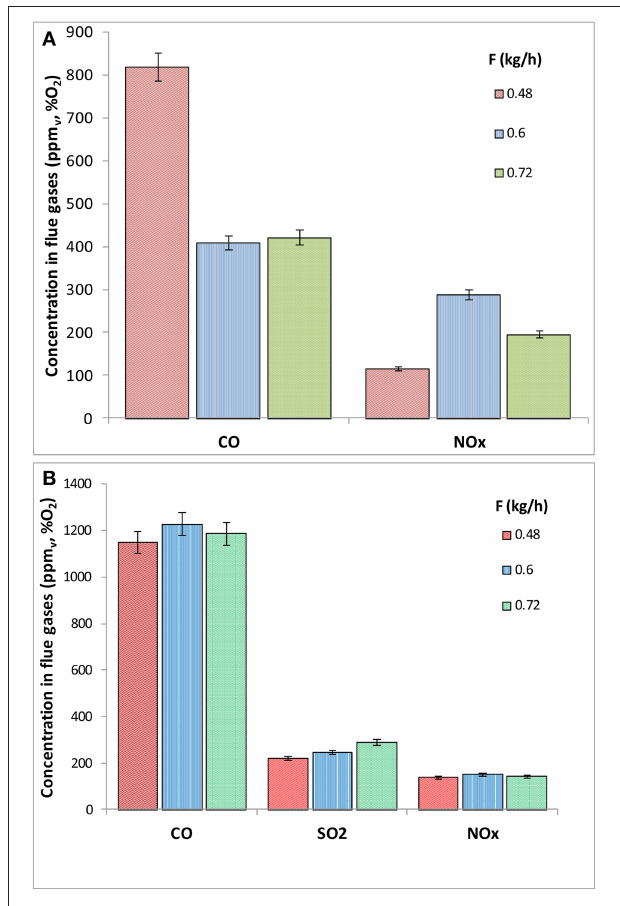
FIGURE 4 | Effect of excess air ratio on average ( ± standard error) flue gas emissions of (A) OS and (B) SS fuels at F = 0.72 kg/h. FIGURE 5 | Effect of fuel feed rate on average ( ± standard error) flue gas emissions for (A) OS and (B) SS fuels at λ =